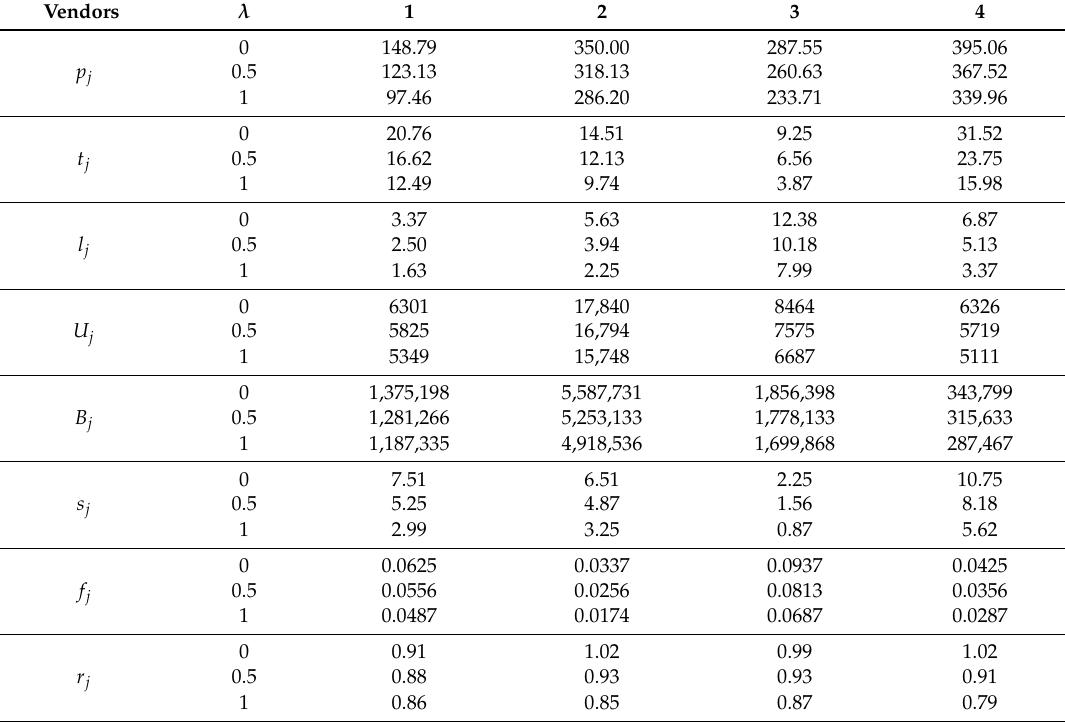
Table 6. Optimistic, pessimistic and most likely value of the parameter for case 2.